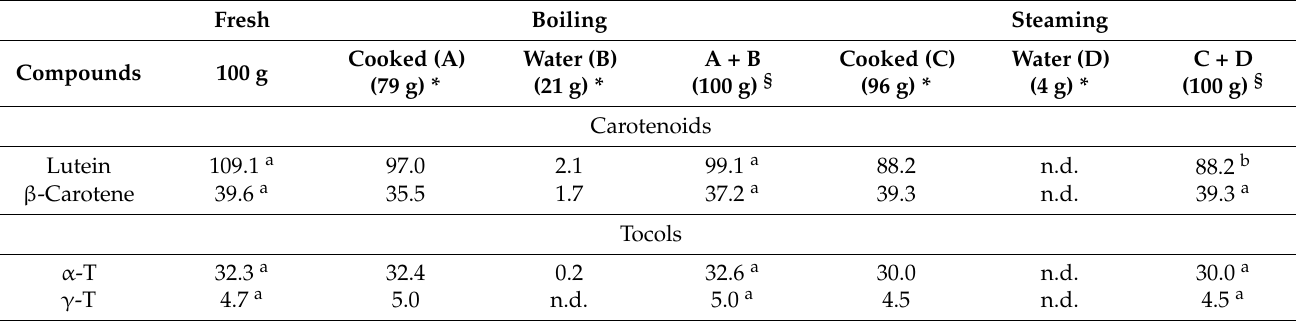
Table 5. Content of the main carotenoids and tocols in fresh vegetables (mg/100 g d.m.), in cooked samples (mg/g d.m.) and in cooking water (mg/g d.m.) of Sp.